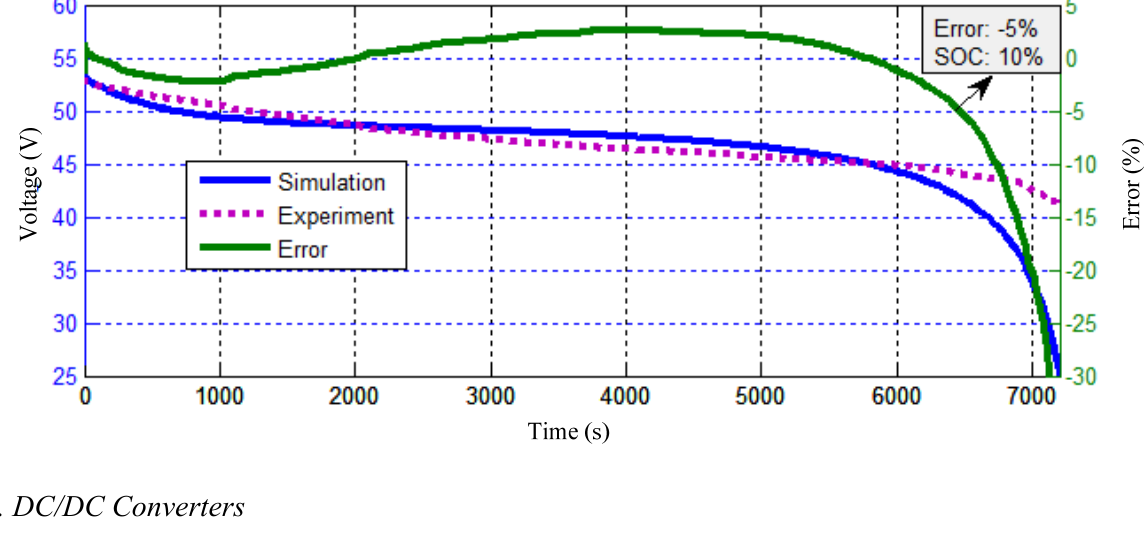
Figure 6. Comparison between experiment and simulation discharge